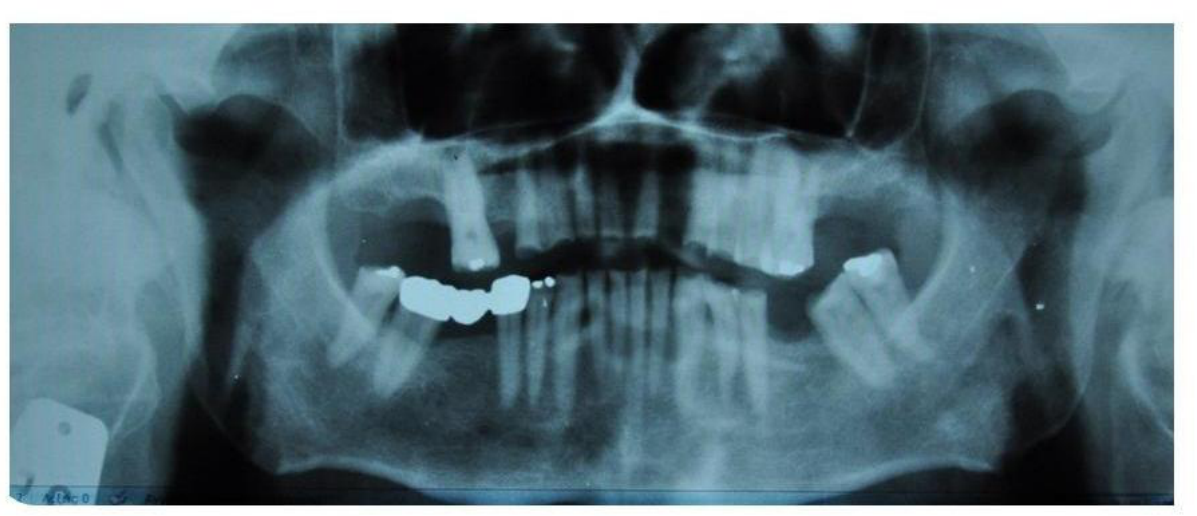
Figure 2. Characteristic screenshot from the OpenLabyrinth case. From the image, the learner is asked if the patient has starting periodontitis, chronic advanced periodontitis, or